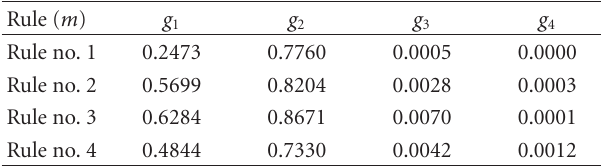
Table 2: Fuzzy densities using GMM.